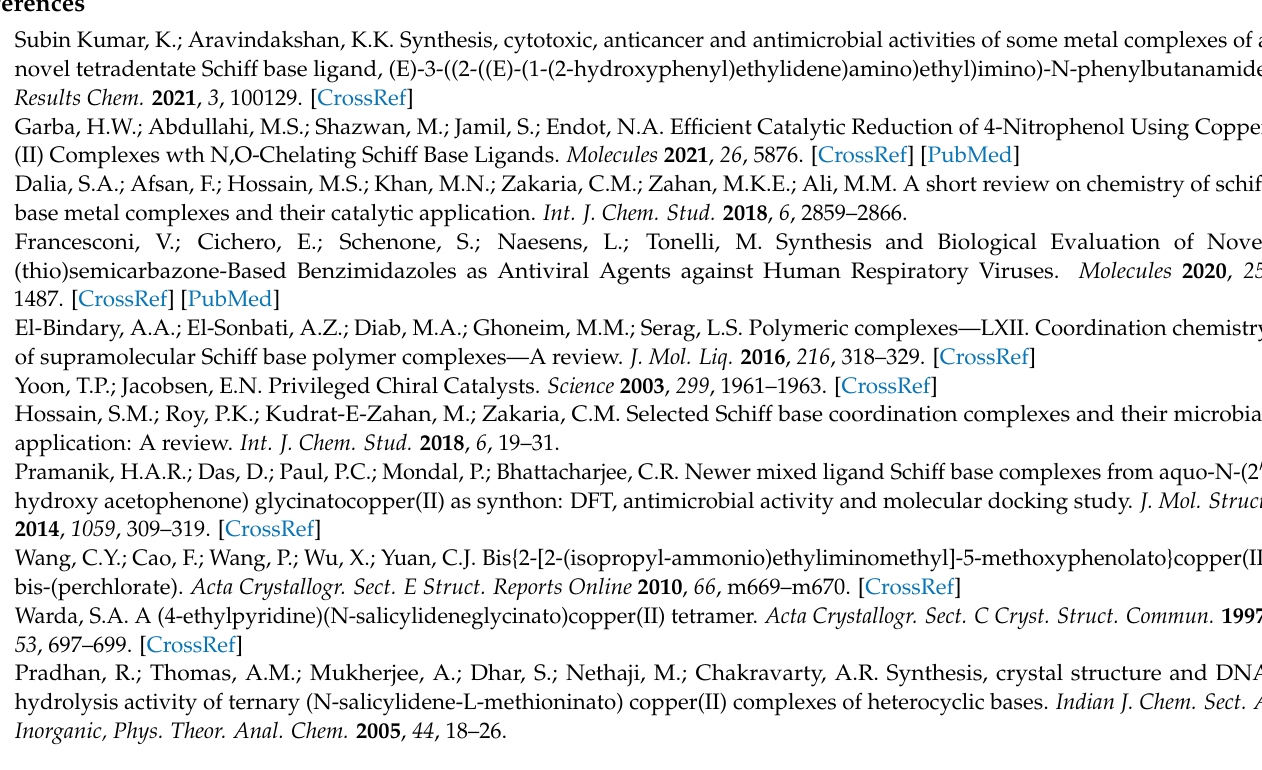
Table S4. Bond lengths for 3 (1), Table S5. Bond angles for 3 (1), Table S6. Hydrogen atom coordinates (Å × 10 4 ) and isotropic displacement parameters (Å2 × 10 3 ) for 3 (1), Table S7. Atomic coordinates ( × 10 4 ) and equivalent isotropic displacement parameters (Å2 × 10 3 ) for 4 (2). U(eq) is defined as one-third of the trace of the orthogonalized Uij tensor, Table S8. Bond lengths (Å) for 4 . Table S9. Bond angles ( ◦ ) for 4 (2). Table S9. Bond angles ( ◦ ) for 4 (2). Table S10. Anisotropic displacement parameters (Å2 × 10 3 ) for 4 (2). The anisotropic displacement factor exponent takes the form: − 2p2 Figure S2. Infrared spectra of the ligand 2 and complex 4 , Figure S3. EPR spectra of complex 3 in polycrystalline at room temperature, Figure S4. EPR spectra of complex 4 in polycrystalline at room temperature, Figure S5. EPR spectra of complex 3 in frozen methanol at 77K, Figure S6. EPR spectra of complex 4 in frozen methanol at